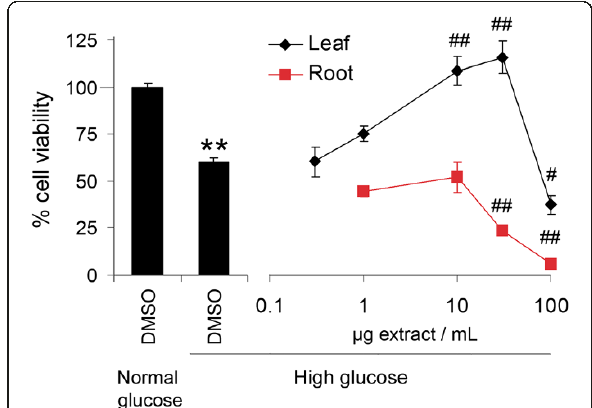
Figure 1 Leaf but not root extract of Sarracenia purpurea protects PC12 cells from high glucose-mediated death. Exposure to glucose toxicity elicited a significant loss in cell viability compared to normal glucose conditions as assessed by mitochondrial dehydrogenase activity measured by cleavage of the formazan dye WST [left panel, ** denotes a significant difference ( p < 0.01) relative to normal glucose control, Student ’ s t -test, n =